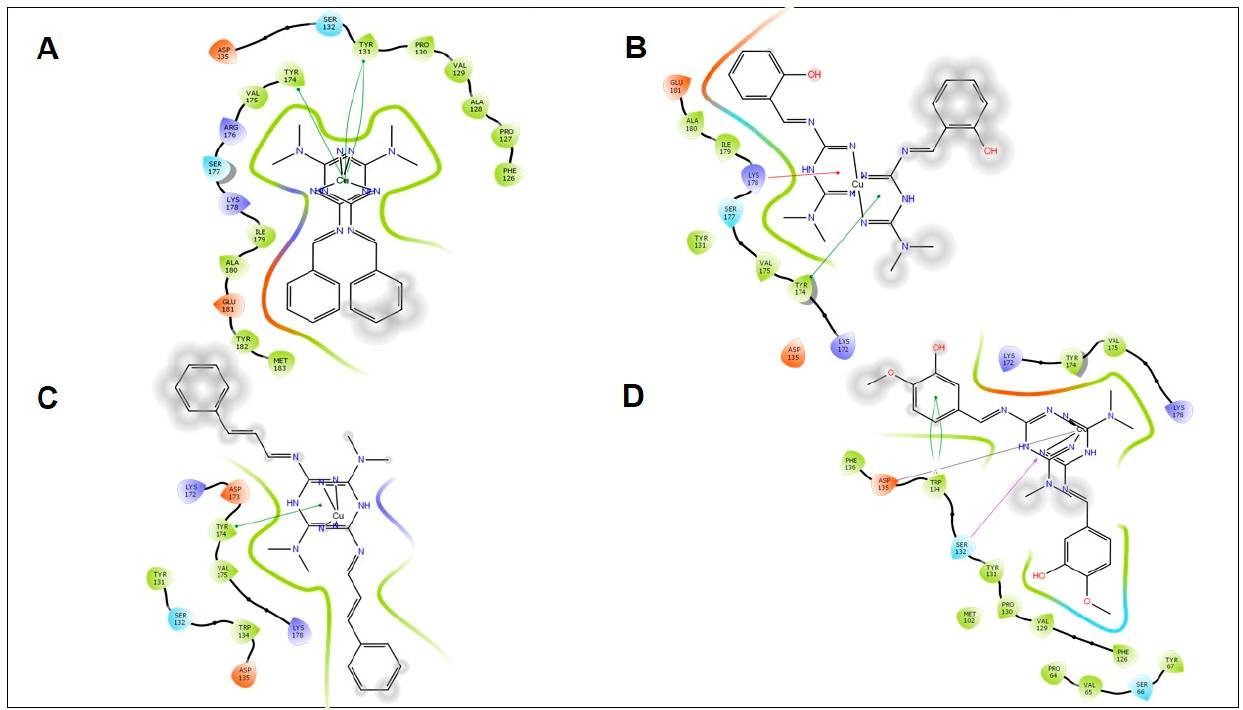
Figure 7. Induced fit docking study of the best pose generated on α -amylase: ( A ) MCu1 ligand-binding site; ( B ) MCu2 ligand-binding site; ( C ) MCu3 ligand-binding site; ( D ) MCu8 ligand-binding site.